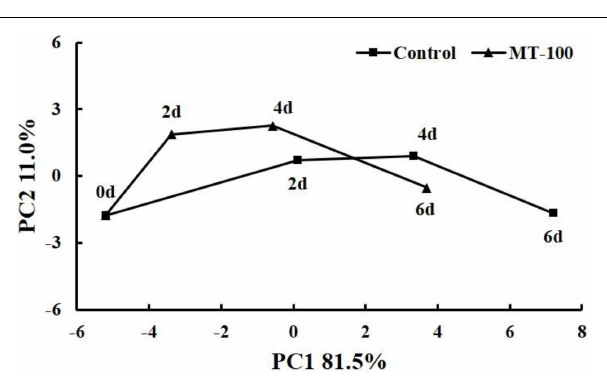
FIGURE 6 | Time-related trajectory plot showing the time-related responses of sensory and nutritional qualities in the lateral buds of baby mustard plants under 100 µ mol L − 1 melatonin treatment during